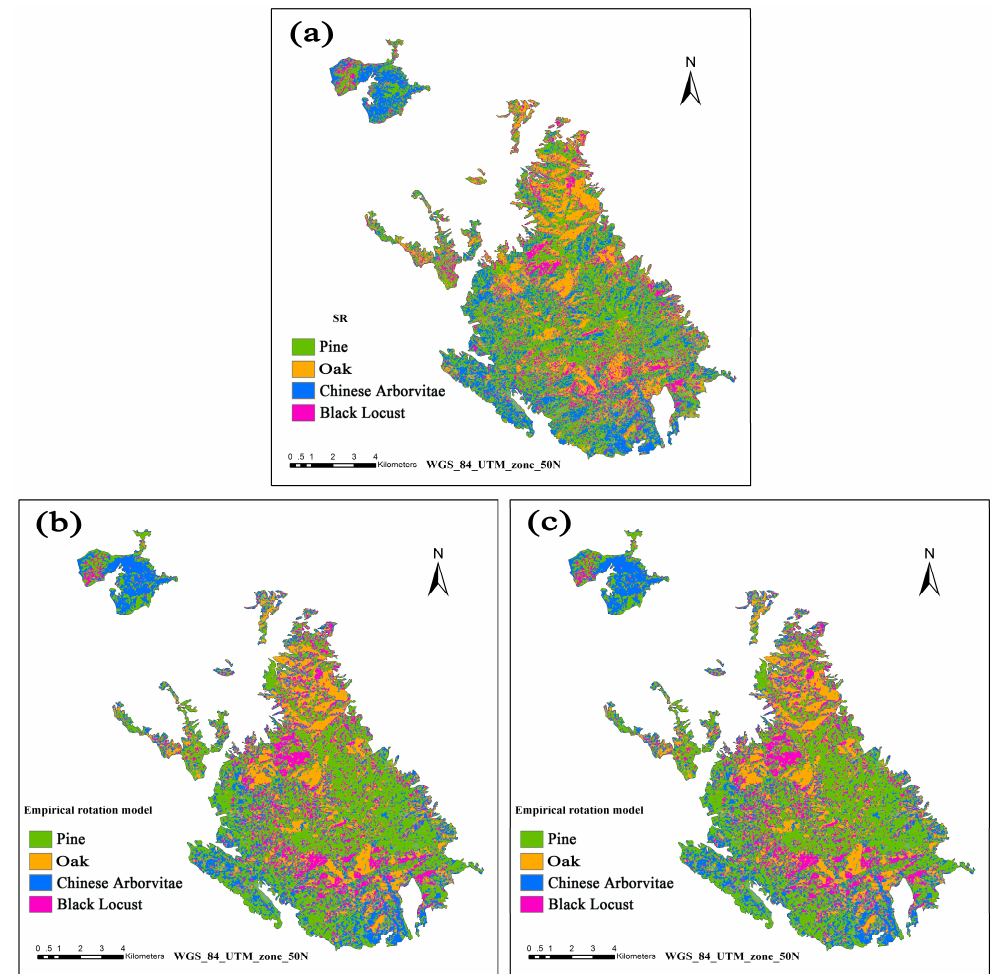
Figure 8. Classification map of the tree species with full-coverage training data. ( a ) Classification result with the precorrected data, ( b ) classification result with topographic correction data of the SCS + C model and ( c ) classification result with topographic correction data of the empirical rotation model. Table 5. Area statistics derived from classification of the tree species. SR represents the data of the precorrected data classification results. The SCS+C model and empirical rotation model represent the data after topographic correction. The gradient represents the change rate between the before and after correction data. Tree Species